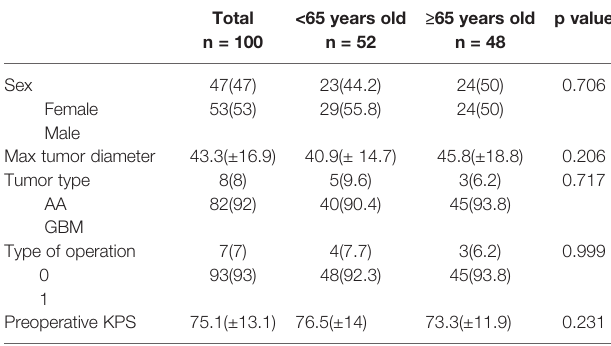
TABLE 1 | Clinical and pathological features of patients strati fi ed for age (<65 years old vs. ≥ 65 years